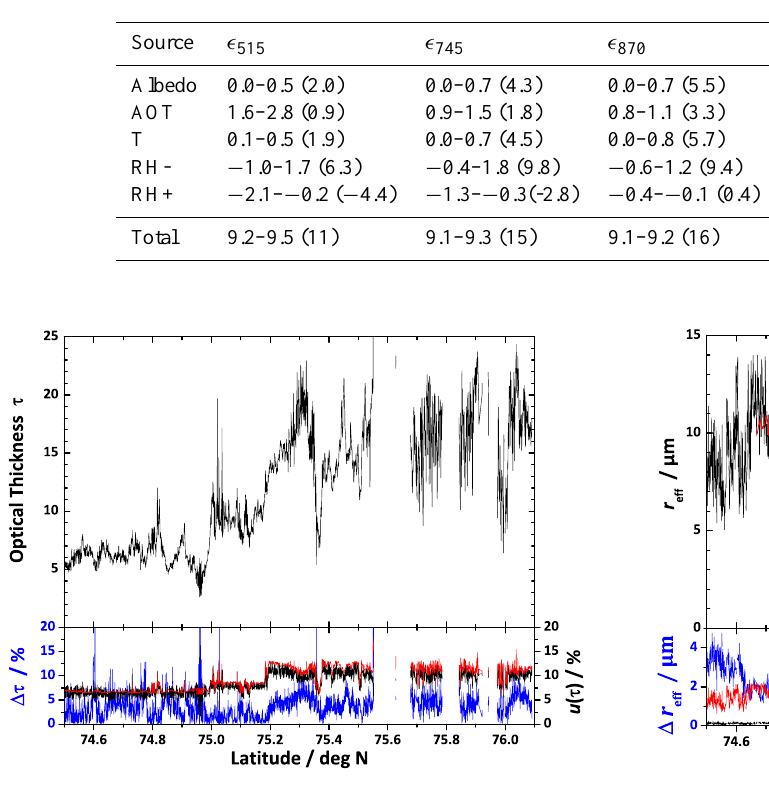
Table 2. Forward model errors (cid:15) (in percent) at the five retrieval wavelengths for different error sources: surface albedo (varied by 10%), aerosol optical thickness AOT (10%), temperature T (6K), relative humidity RH ( ± 40%). The total includes the measurement uncertainty for radiance (9%). Values in parentheses are for the case τ = 0.